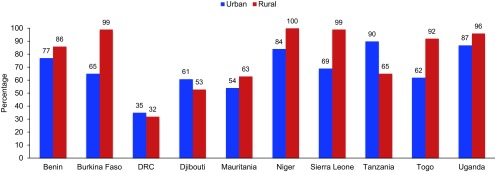
Percentage of Health Facilities Providing Family Planning, by Urban and Rural LocationAbbreviation: DRC, Democratic Republic of the Congo.